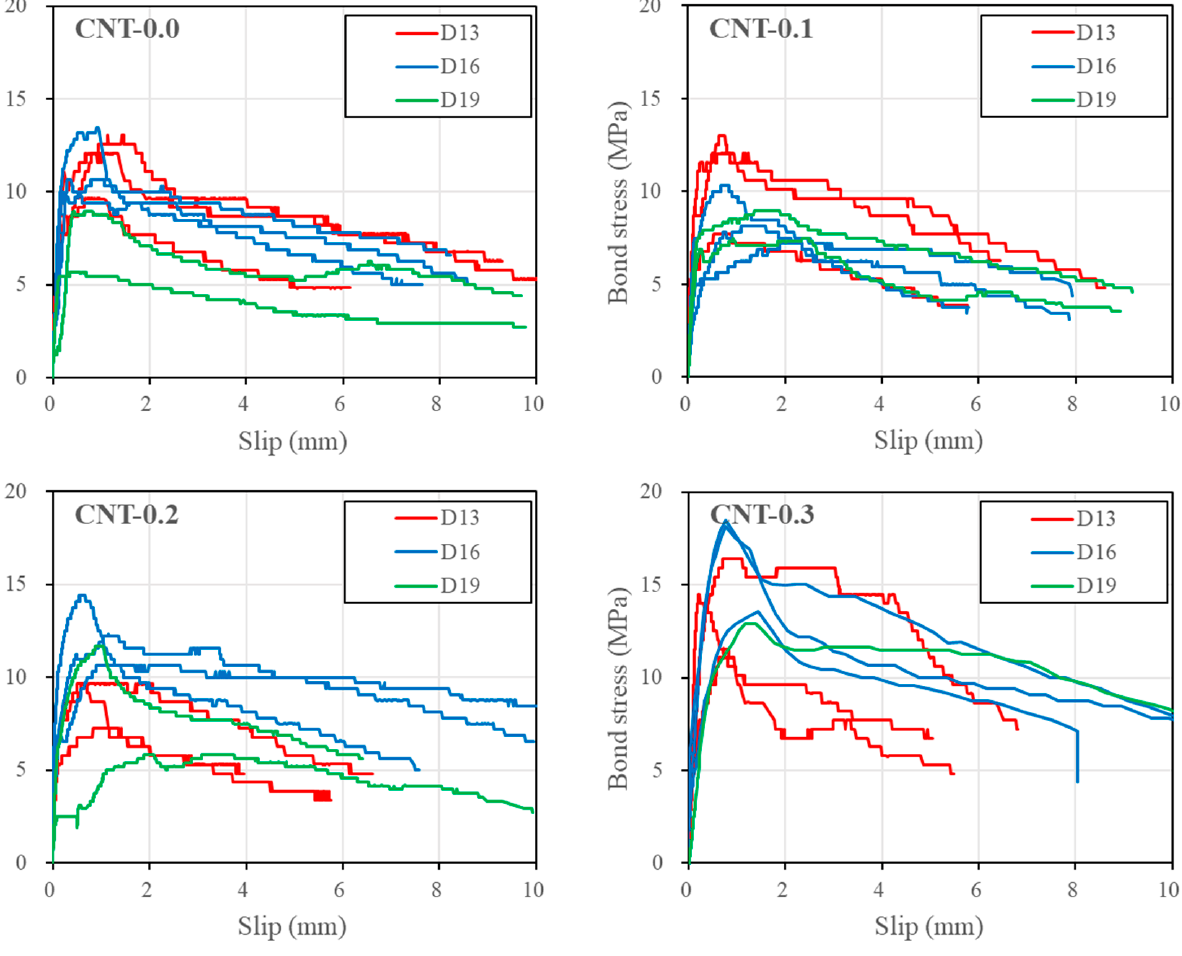
Figure 8. Bond stress-loaded end slip responses of a rebar embedded in PVA cementitious composites with CNTs.